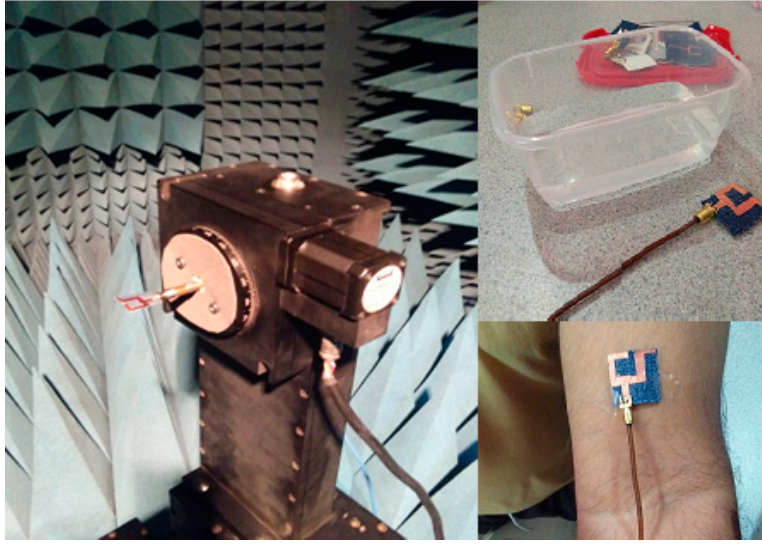
Figure 10. Measurement setup of the anechoic chamber, wet and on body situations.